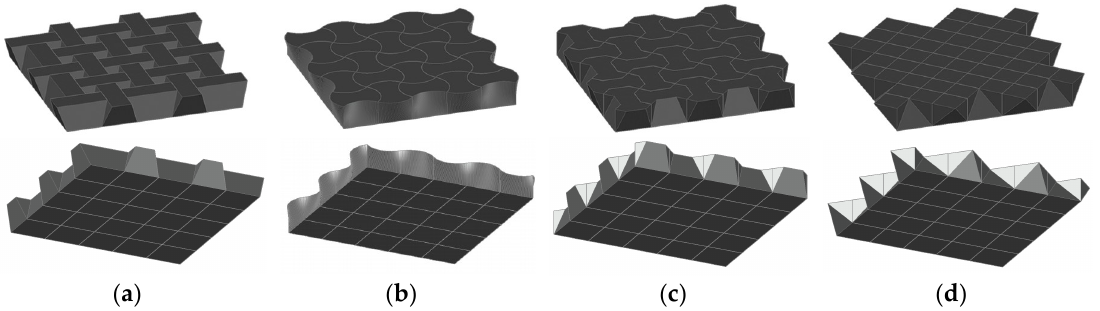
Figure 1. Flat vaults: ( a ) of Abeille (1699); ( b ) of Truchet (1699); and ( c , d ) of Frezier (1735).